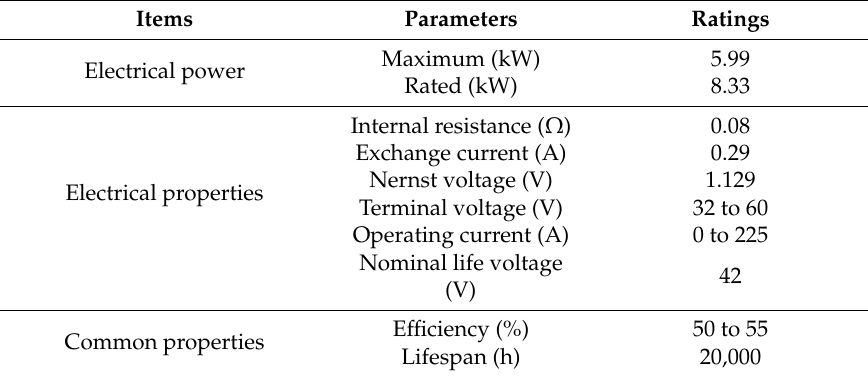
Table 1. Electrical parameters of the fuel cell.